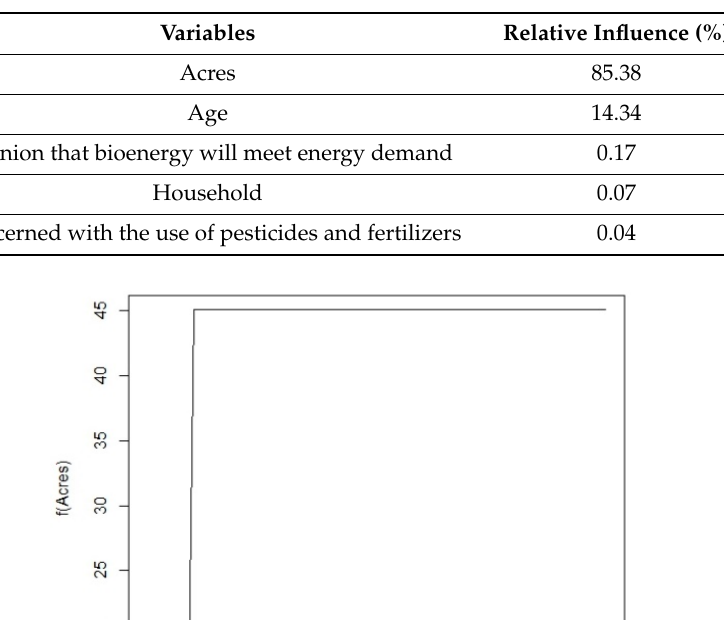
Table 8. Variables and their relative influence on landowners’ acreage commitment to rent.